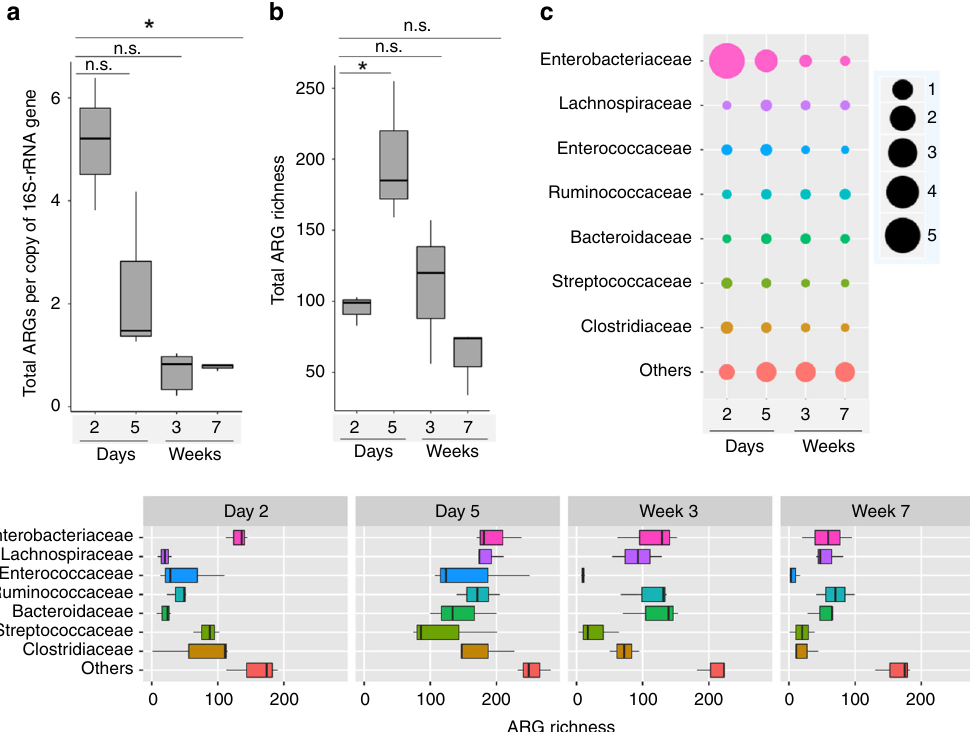
Fig. 3 The dynamics of the dairy calf fecal resistome over time. a Boxplot (boxes representing IQRs with median shown in black) of the distribution of total ARG abundance in dairy calves from day 2 to week 7. b Boxplot of the number of unique ARGs observed in dairy calves over time. c The predicted bacterial families of ARGs and associated resistance gene abundance in dairy calves. The fi rst 7 families, which are predicted to represent 69.45% of the total ARG abundance and 96.66% of the ARG diversity, are listed here, and the remaining bacterial taxa are grouped into the “ Others ” category. The taxonomy of ARGs was estimated by assigning taxa at the family level to ARG-containing metagenomic-assembled contigs (see Methods). The size scales with the normalized abundance of ARGs (per copy of 16S rRNA gene) assigned to the particular family at each time point, and colors were used to distinguish different taxa. d The predicted ARG richness of each bacterial family over time. The richness is de fi ned as the number of unique ARGs detected during the AMR ++ analysis (see Methods). * P <0.05, and n.s. indicates P >0.05 by Friedman ’ s test followed by multiple pairwise comparisons using Nemenyi post-hoc test